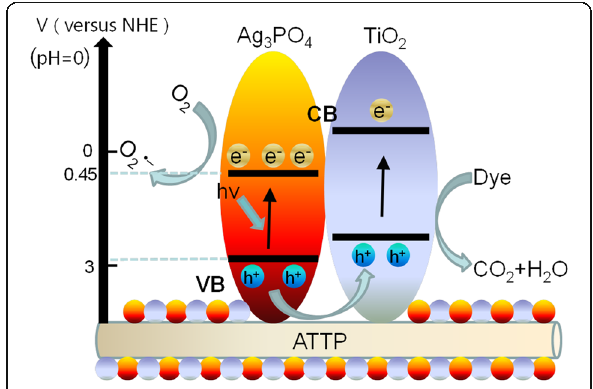
Fig. 7 Proposed photocatalytic mechanism of ATP/TiO 2 /Ag 3 PO 4